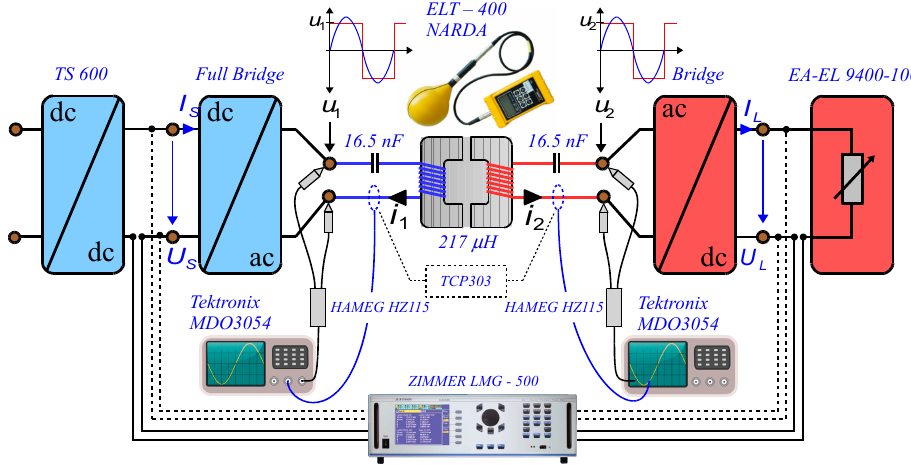
Figure 17. Graphical interpretation of experimental measurement set-up.